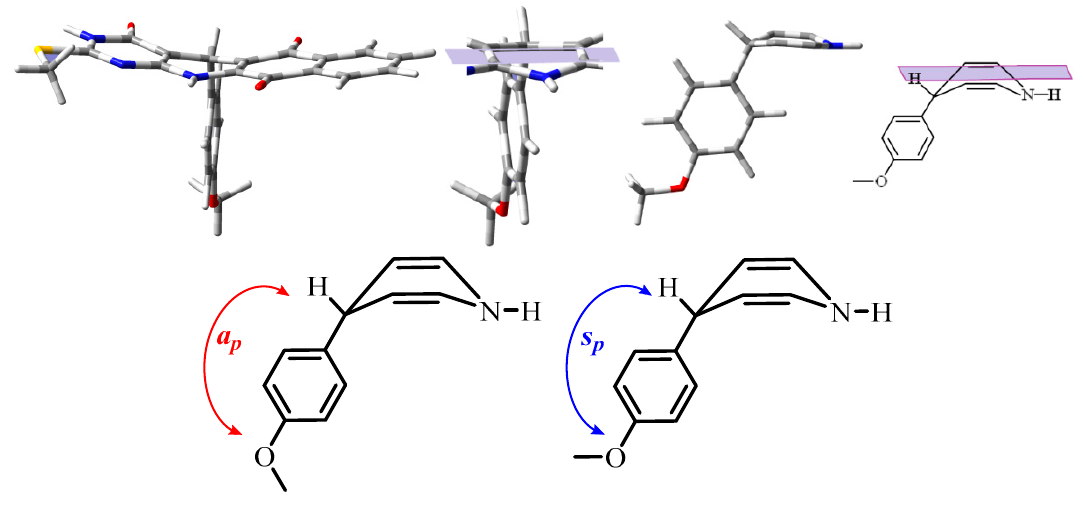
Figure 3. Conformation of the dihydropyridine ring in the structure of compound 4c .